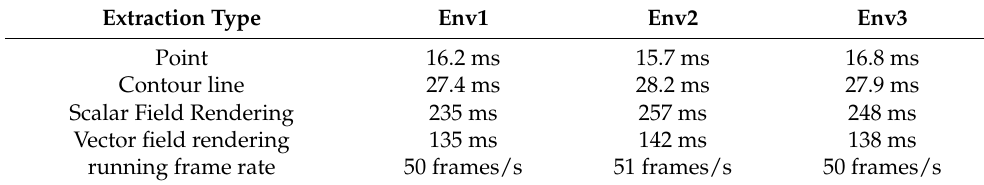
Table 3. Data extraction speed test